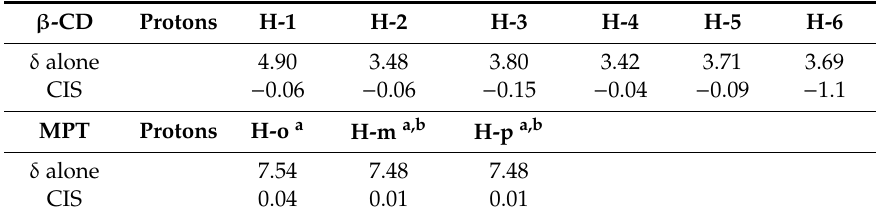
Figure 2. The 1 H NMR spectra in D 2 O for solutions of ( a ) β -CD; ( b ) MPT; ( c ) equimolar amount of β -CD and MPT. Table 1. The 1 H-NMR chemical shifts ( δ , ppm) for H protons of β -CD alone, MPT alone, and complexation induced shifts (CIS = δ complex – δ free ) of equimolar amounts of them in D 2 O at 23 °C.